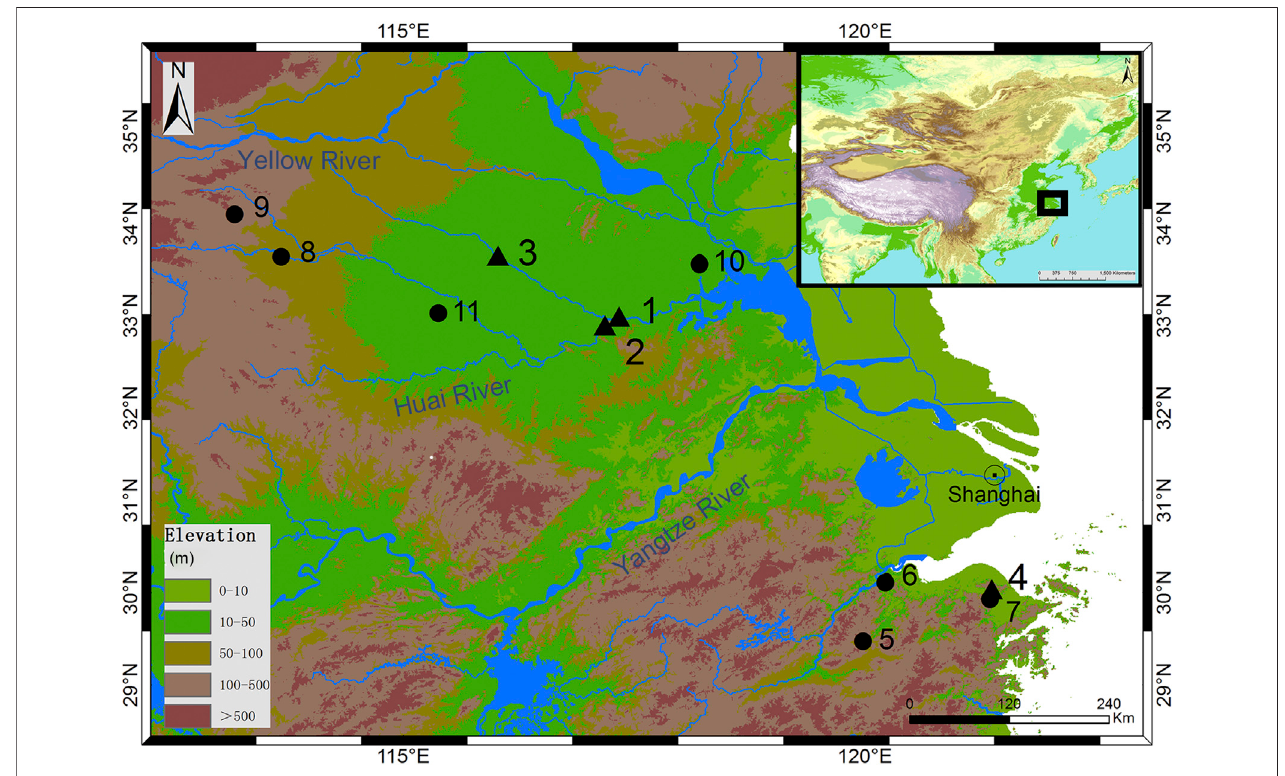
FIGURE 1 | Locations of the sites for study and other sites mentioned in the text (1. Shuangdun; 2. Yuhuicun; 3. Houtieying; 4. Tianluoshan; 5. Shangshan; 6. Kuahuqiao;7.Hemudu;8.Jiahu;9.Tanghu;10.Shunshanji;11.Gongzhuang;blacktrianglesindicatethesitesforcoproliteanalysisinthisstudyandblackdotsindicate the sites mentioned in the